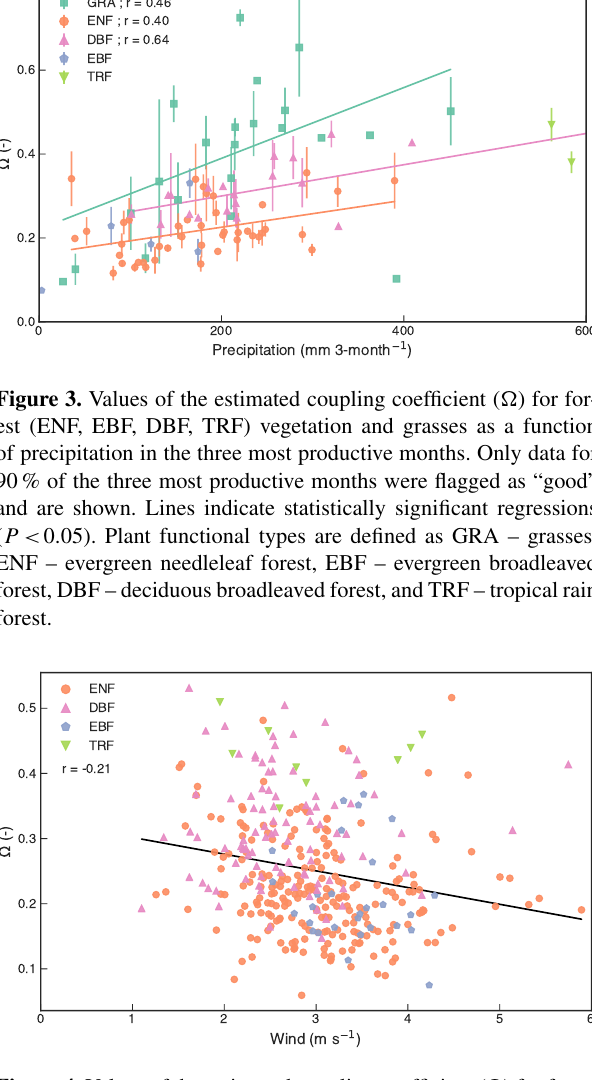
(Fig. 4). For non-forest PFTs, we did not find a significant relationship between wind speed and